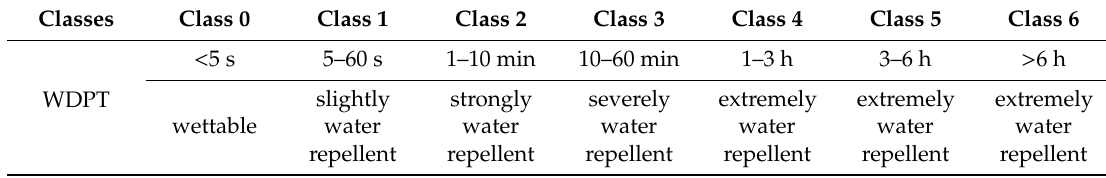
Table 3. Classes of water drop penetration time (WDPT) used in this